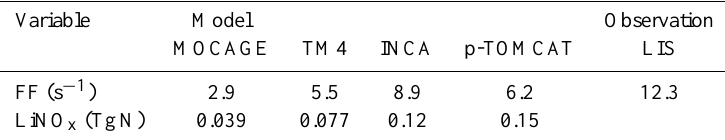
Table 2. Simulated total FF and LiNO x production over Africa (20 ◦ S–30 ◦ N and 20 ◦ W–40 ◦ E).